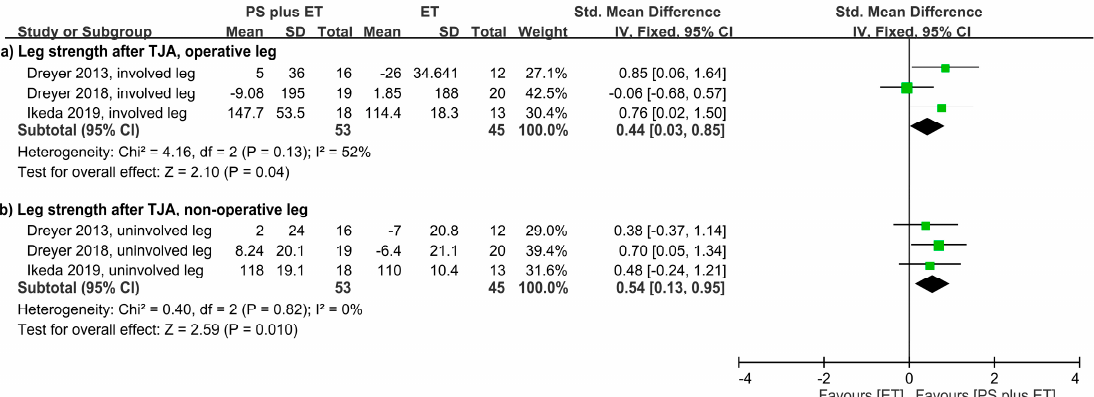
Figure 4. Forest plot summarizing the e ff ects of postoperative protein supplementation (PS) plus exercise training (ET) on changes in muscle strength of ( a ) the involved leg and ( b ) the contralateral uninvolved leg over the overall follow-up period. The square represents the point estimate of the intervention e ff ect for each trial. The horizontal line links the lower and upper limits of the 95% CI for the given e ff ect. The area of the squares indicates the relative weight of the trials in the meta-analysis. Trial results plotted on the right-hand side of the vertical axis indicate e ff ects in favor of protein supplementation. The combined e ff ects are plotted using black diamonds. 95% CI, 95% confidence interval; Std, standard; IV, inverse variance; TJA, total joint arthroplasty.